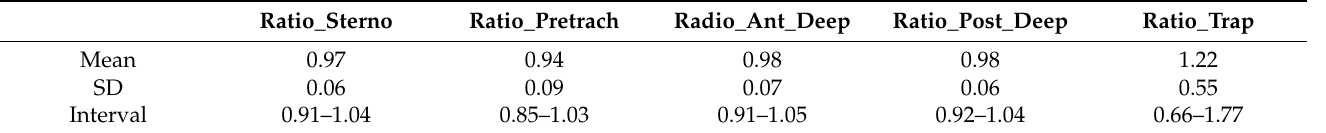
Table 1. Ratio of muscle volumes for each muscle group (right to left side) in the control group.